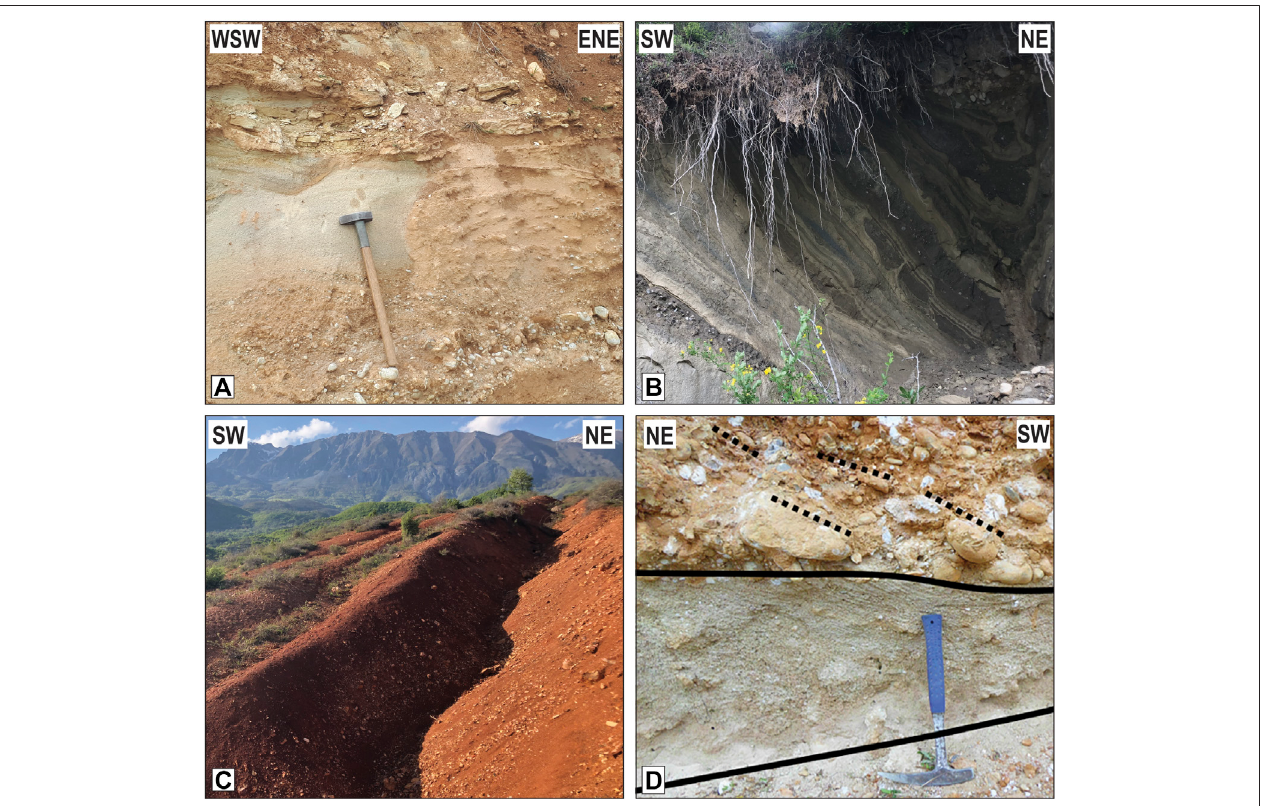
FIGURE 5 | Lithologies of the Tropoja Basin: (A) Unit 1: Grey marl and conglomeratic layers. The hammer is ~55 cm long; (B) Unit 1: grey marl and intercalated sandstone with bedding locally tilted to the NW; (C) Unit 3: Red beds (Terra Rossa) at the northern margin of the basin with layers of round pebbles; (D) Unit 2: Carbonate-rich conglomerate with inclined bedding overlying carbonaceous sandstone between black lines. Length of hammer ~33 cm. Locations of pictures labelled a – d in Figure 4A .